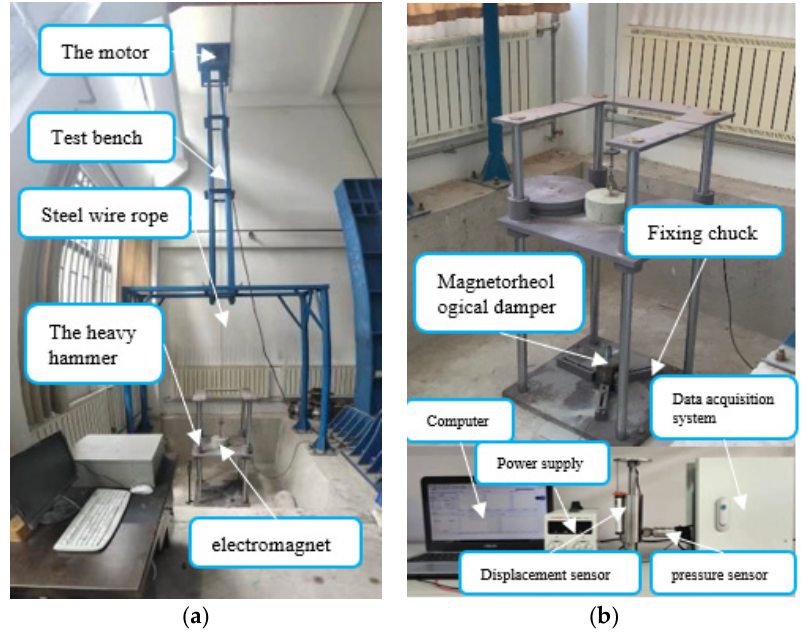
Figure 24. Impact test bench. ( a ) A diagram of the whole test system; ( b ) local detail diagram of test system.